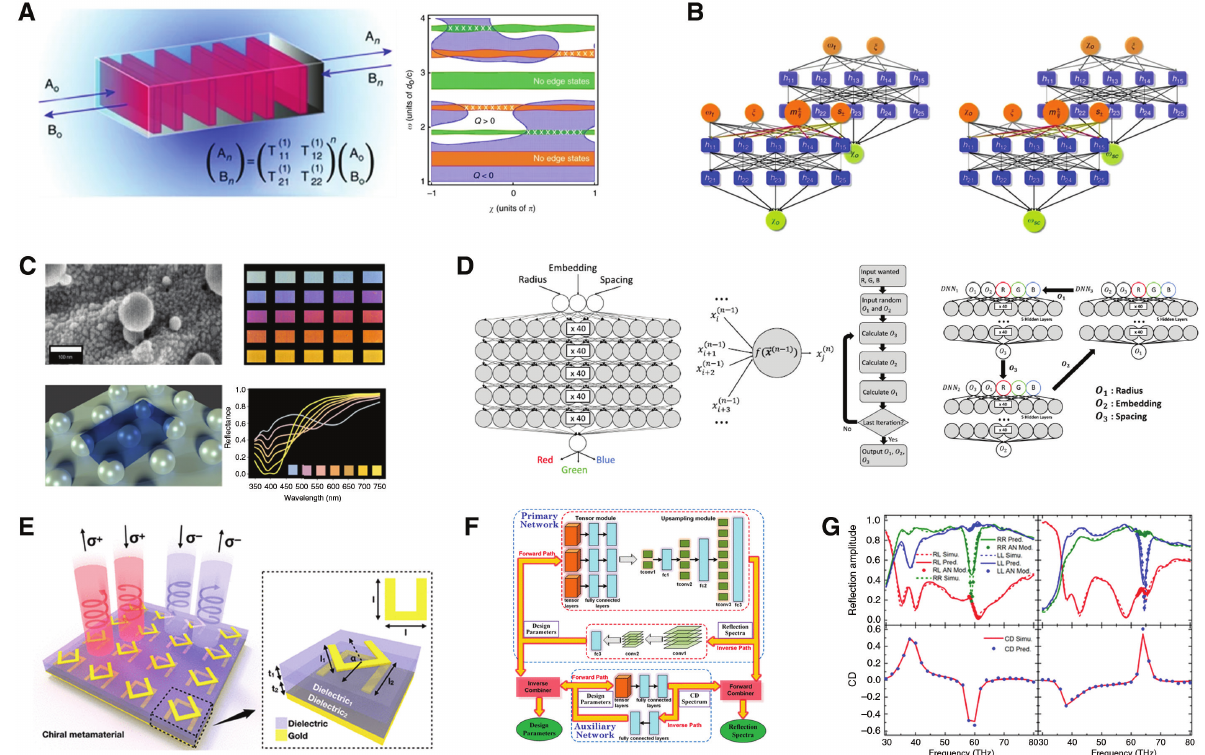
Figure 4: Practical applications of DL for inverse design in nanophotonic structures. (A) A schematic of the topological insulator and its edge state obtained from transfer matrix. (B) Direct and inverse networks used to find the specific edge state frequency. (C) Laser machined silver surface and its color representation. (D) Iterative DNN inverse design. (E) A schematic of the two-layer split-ring resonator. (F) The DNN design, including the forward modelling and inverse design. (G) An example of (C–D) are adapted with permission from Ref. [52] (CC BY 4.0). (E–G) are reprinted with permission from Ref. [68], Copyright 2018 American Chemical